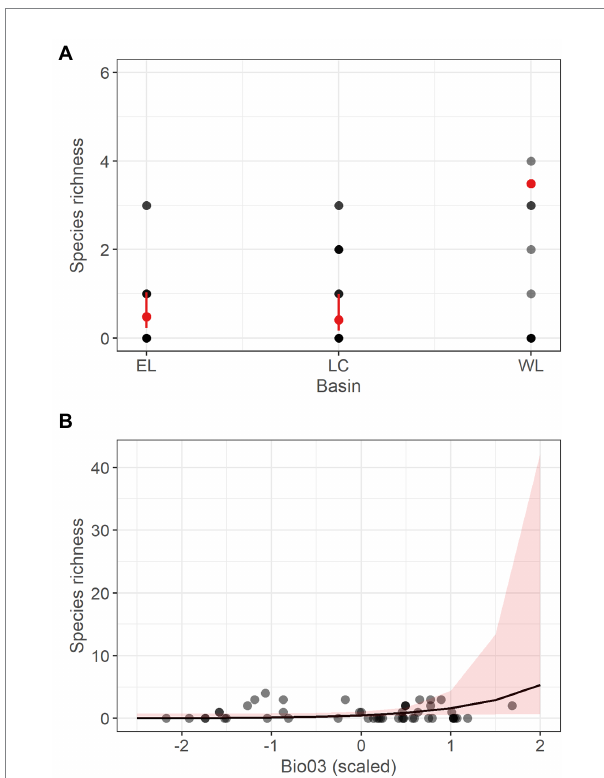
FIGURE 4 Marginal response plots showing the effect of drainage basin (A) and scaled isothermality (Bio03) values (B) on predicted species richness of non-stygobitic Cyclopoida, as resulting from the corresponding Generalized Linear Model. In (A) , red dots and related bars show predicted values and the corresponding 95th percentile confidence interval. In (B) , the black curve corresponds to predicted marginal response with the surrounding shaded area representing the 95th percentile confidence interval. In both plots, grey-scale dots represent observed values, with darker dots indicating multiple observations with the same richness